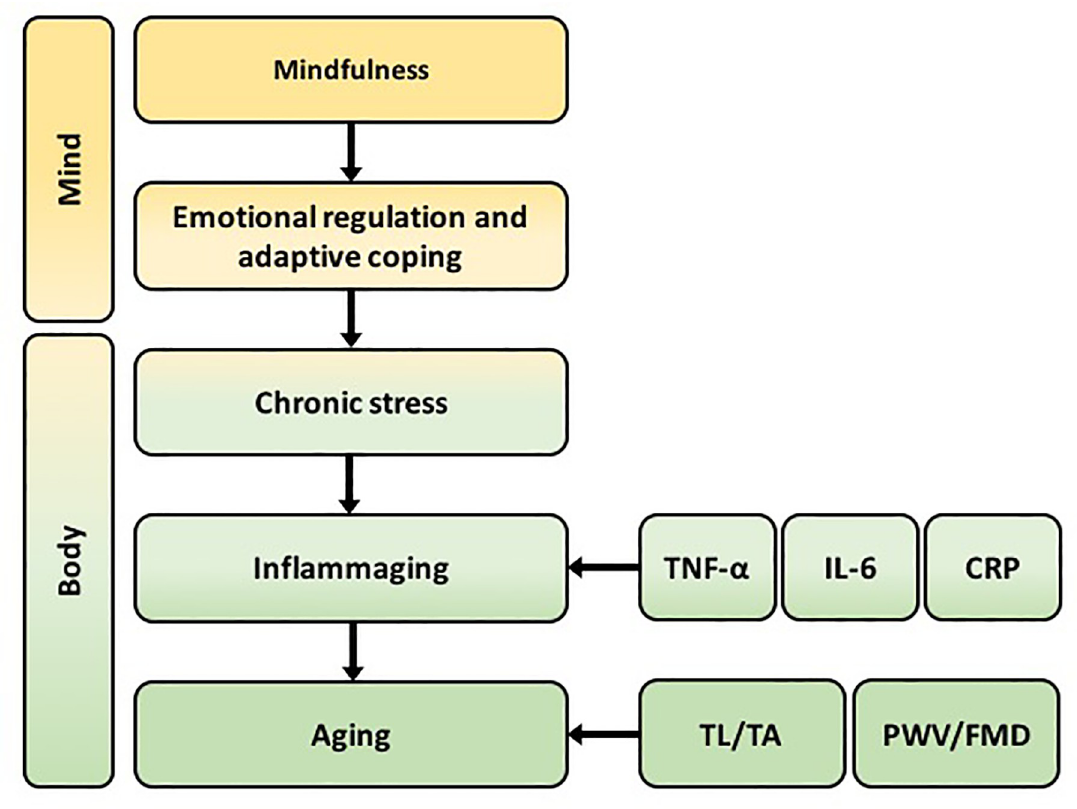
Fig 1. A schematic depiction of how BMIs might influence inflammaging and aging.